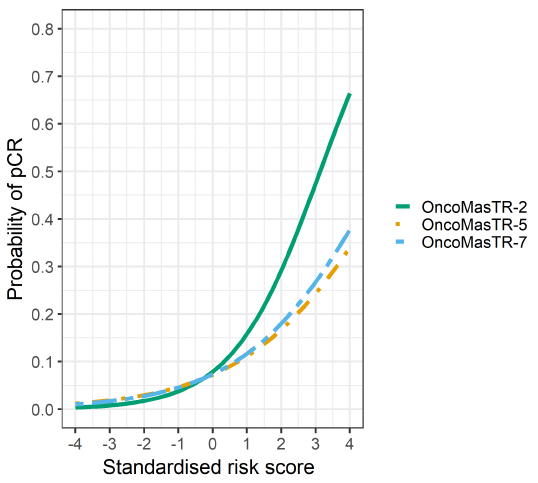
Figure 5. Predicted probability of pCR by OM risk score using different dataset groups. Green line complete OM genes (2 datasets); Orange line incomplete OM genes (5 datasets missing ZNF367); Blue line combined datasets (7